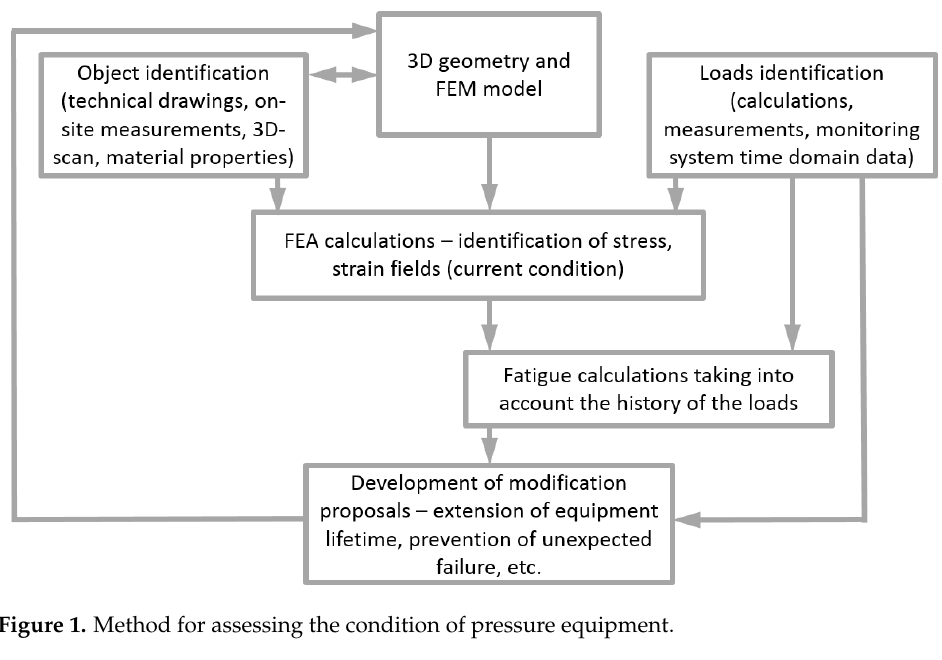
Figure 1. Method for assessing the condition of pressure equipment.